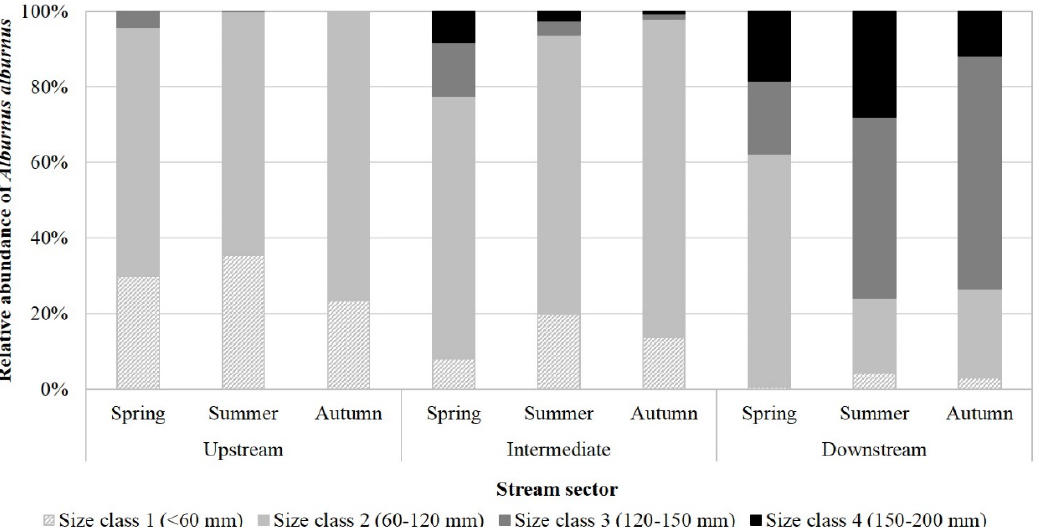
Figure 4. Relative abundance of the size classes defined for Alburnus alburnus in each stream sector over the sampled periods of year.